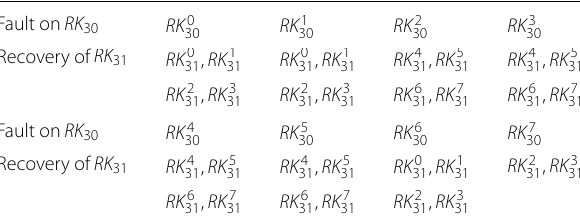
Table 5 The discussions on the recovery of the last round